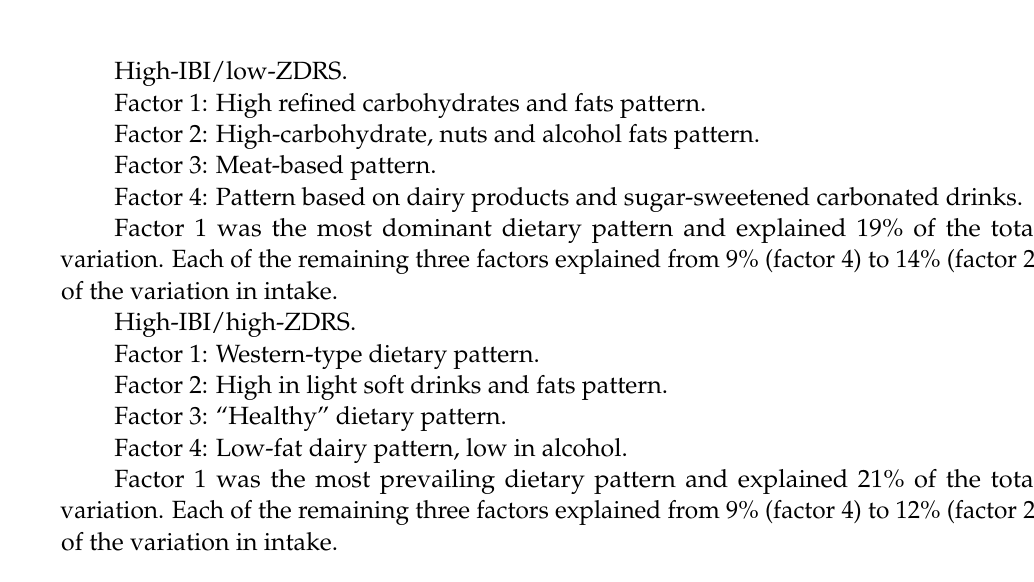
Table 4. Factor coefficients loadings regarding foods or food groups consumed by Greek ATTICA study participants with a high IBI score ( ≥ 52), who also had depression symptoms (ZDRS > 34) ( n = 853) at